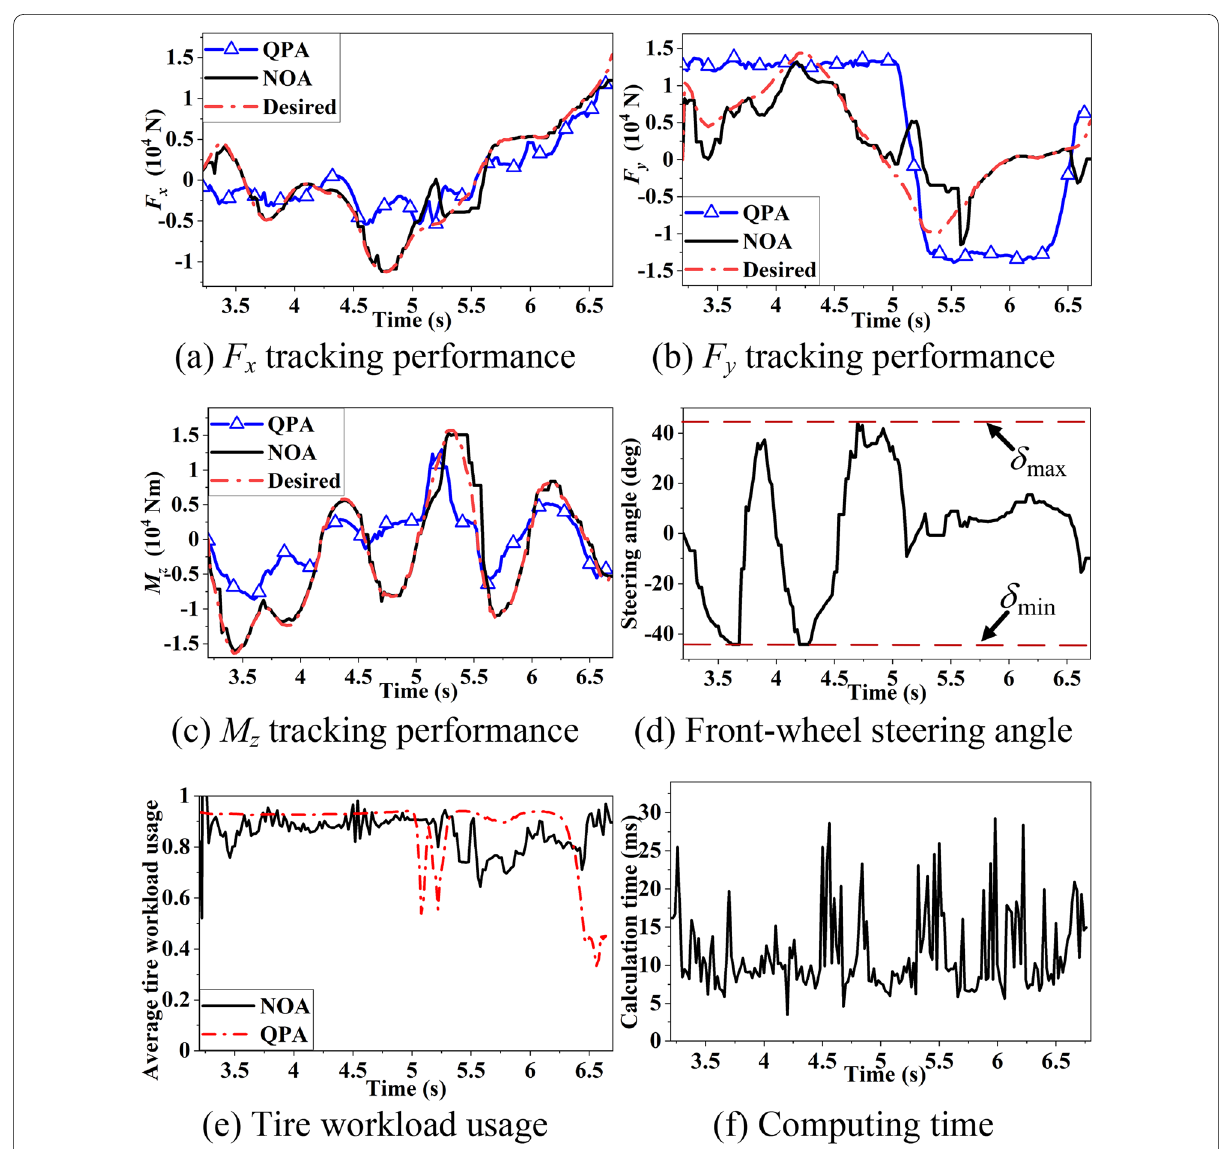
Figure 13 Performance comparison of different control allocation